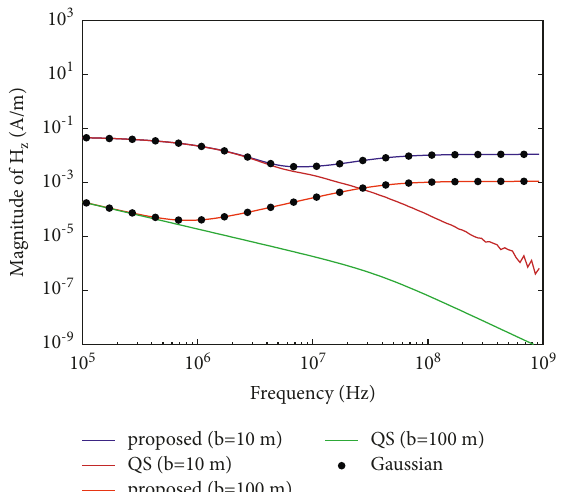
Figure 3: Relative error of the outcomes of (37) as compared to the − field at the z results from (34), plotted against frequency.